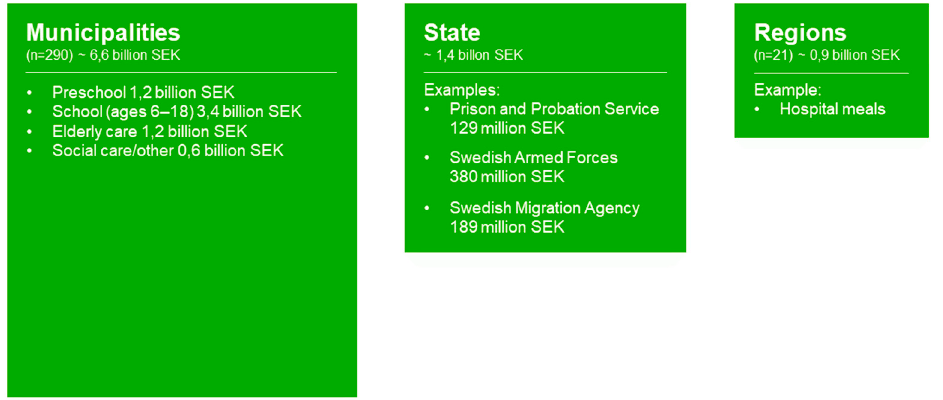
Figure 1. The figure illustrates different sectors serving meals to users. The sizes of the boxes correspond to the number of meals served in each arena, based on a Swedish context [33–35].